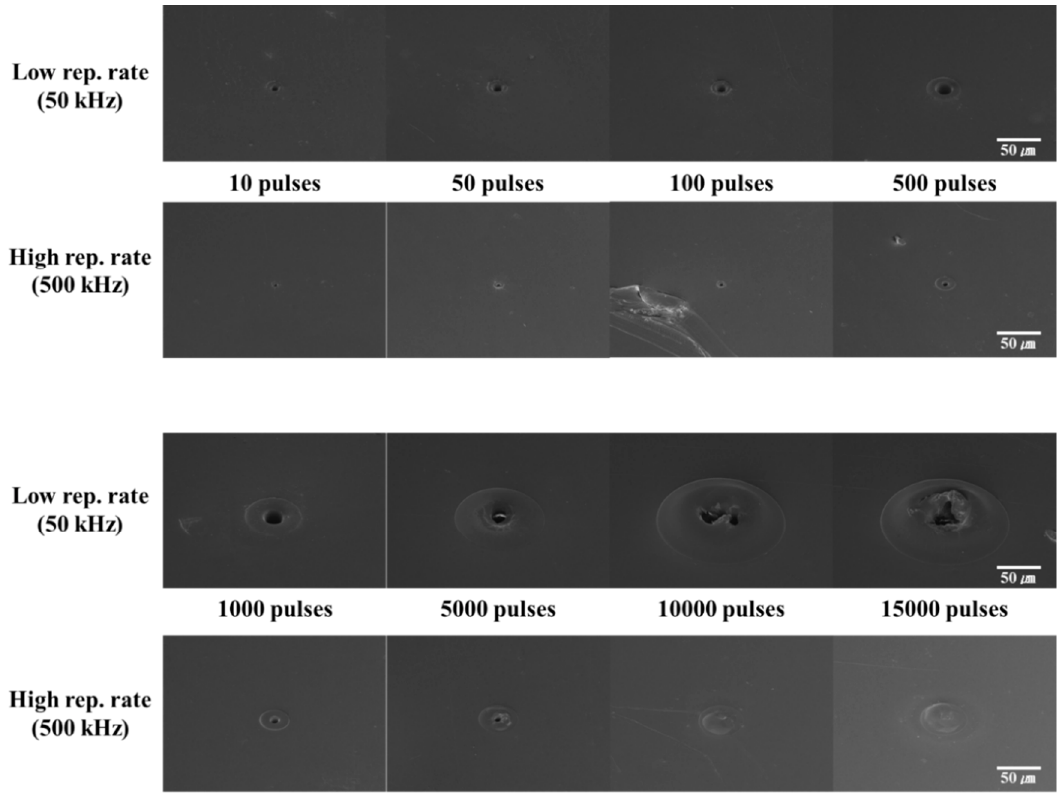
Figure 5. SEM images of the laser processing results of polyethylene terephthalate (PET) under stationary beam irradiation with the same average power.